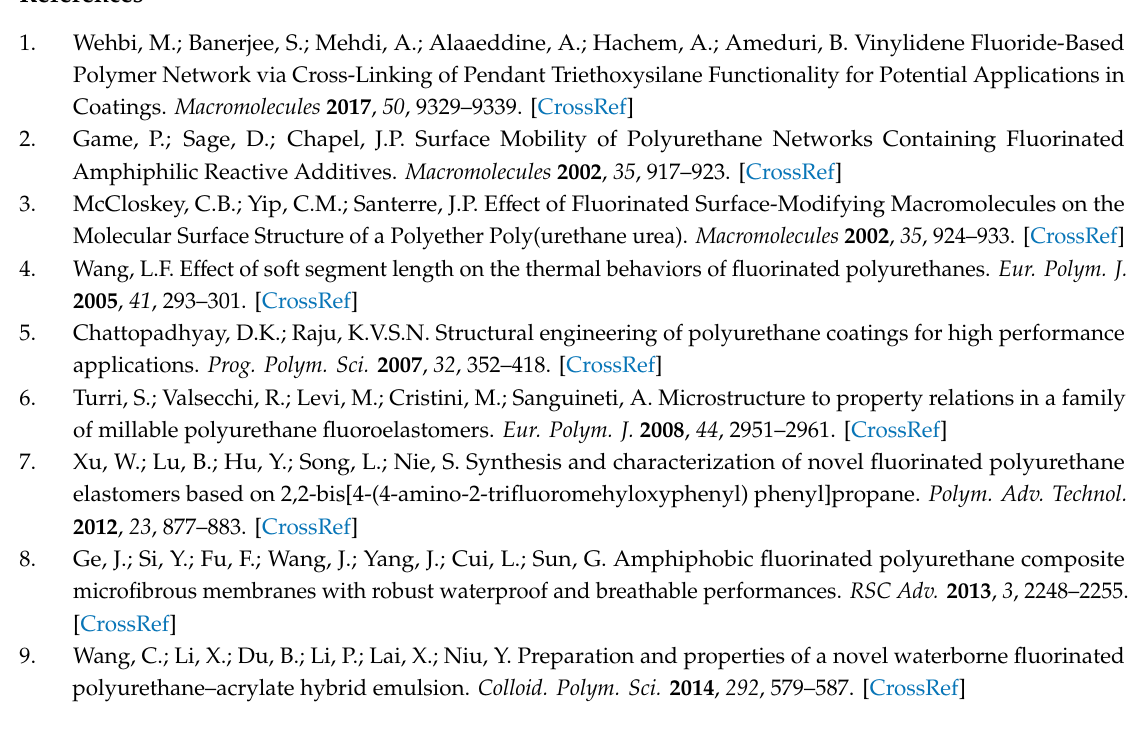
Figure S1. 1H NMR spectrum of BEDTC recorded in CDCl3 at room temperature; Figure S2. 13C NMR spectrum of BEDTC recorded in CDCl3 at room